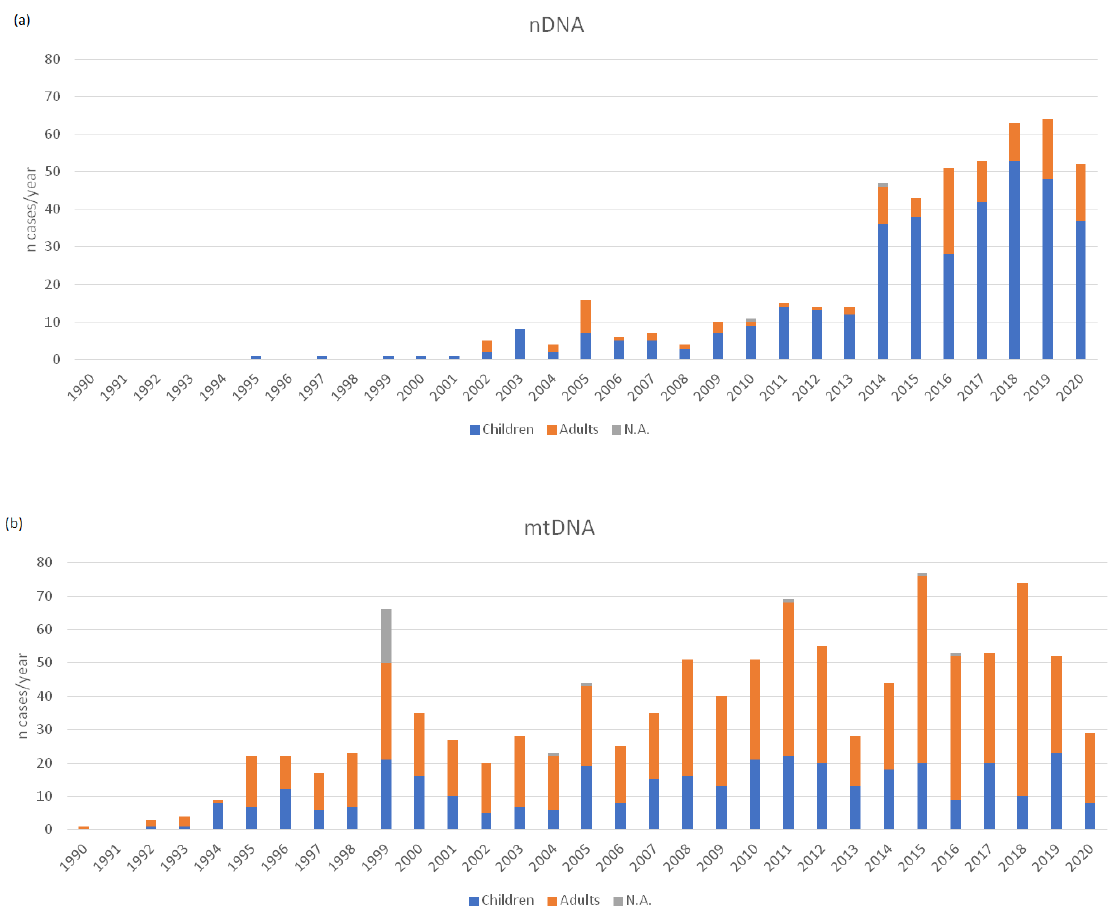
Figure 1. Number of cases diagnosed per year and age. ( a ) Cases harbouring nuclear DNA (nDNA) mutations; ( b ) cases harbouring mitochondrial DNA (mtDNA) mutations. Abbreviations: N.A., not available.